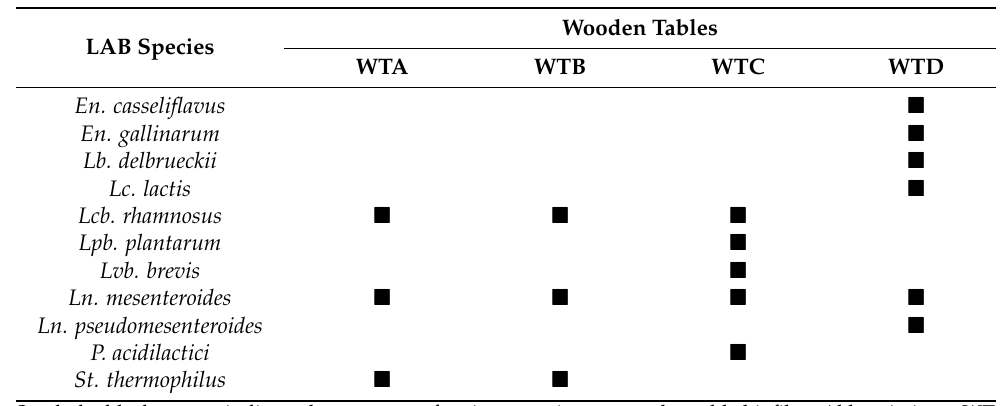
Symbols: black square indicate the presence of a given species on wooden table biofilm. Abbreviations: WT, wooden table; A–D, dairy factory A–dairy factory D; En. , Enterococcus ; Lb. , Lactobacillus ; Lc. , Lactococcus ; Lcb.